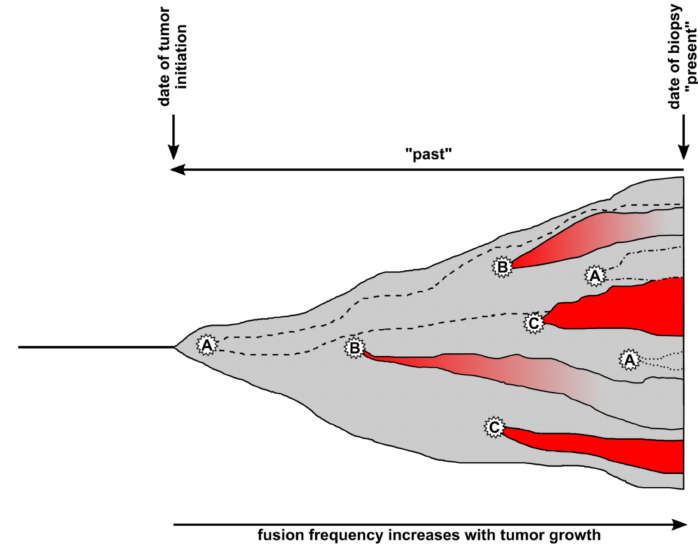
Figure 2. Timeline of cell fusion events inside a tumor tissue. Cell fusion events can occur at any time inside a tumor tissue (gray), whereby the fusion frequency should increase with tumor size. Whether hybrid cells will become visible or part of the dark matter (invisible) will depend on which cell types fuse and if they retain or lose specific marker expression. A, Tumor cells could either fuse with each other (homotypic fusion) or with normal cells expressing similar markers (heterotypic fusion) resulting in invisible/dark matter hybrids. Such hybrids are indistinguishable from nonfused tumor cells (gray) but contribute to tumor heterogeneity and tumor growth (dashed and dotted lines). B, Heterotypic cell fusion between tumor cells and normal cells results in TN-hybrid cells that have lost specific marker expression over time and become part of the dark matter. A switch from red to gray indicates the loss of specific marker expression. C, Heterotypic cell fusion between tumor cells and normal cells results in TN-hybrid cells that have retained normal cell marker expression over time and can be detected in the